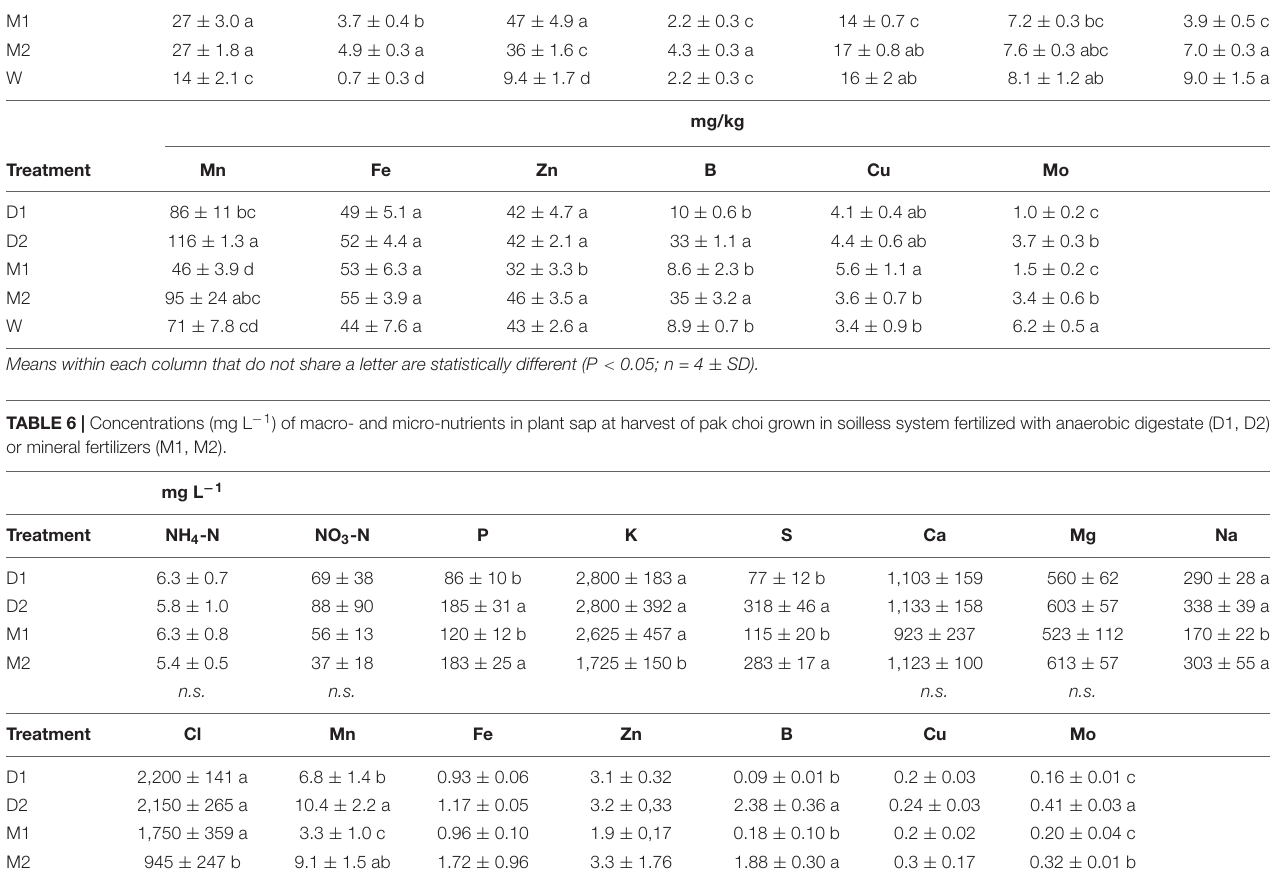
TABLE 5 | Concentration of nutrients in shoot dry matter at harvest of pak choi grown in soilless system fertilized with anaerobic digestate (D1, D2) or mineral fertilizers (M1, M2). Treatment N